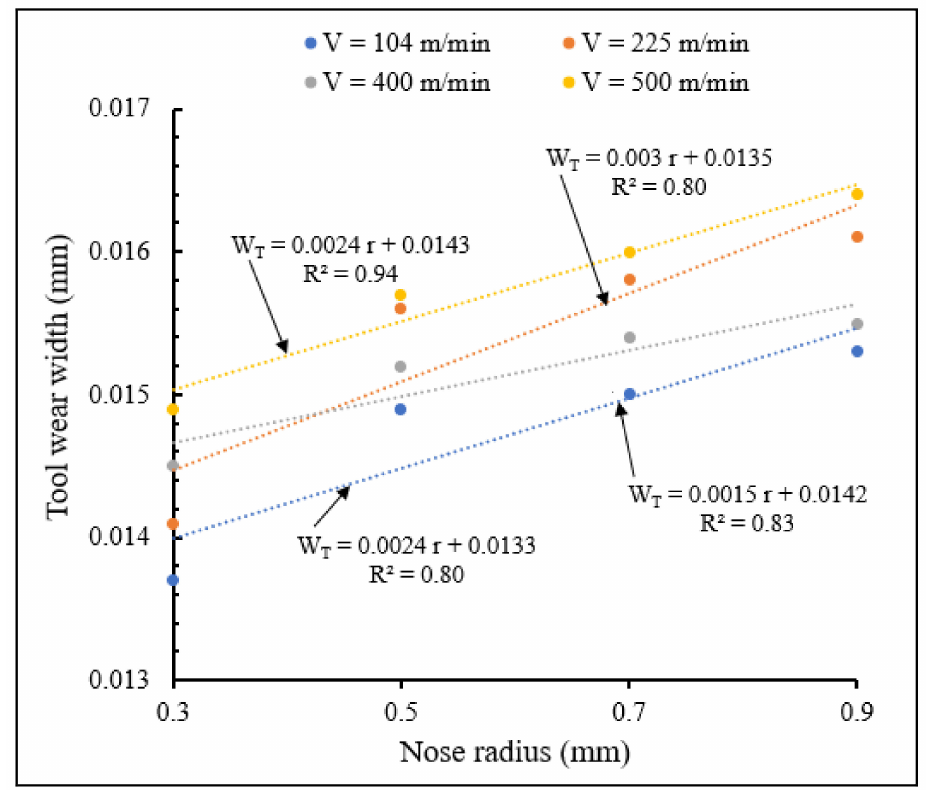
Figure 25. Variation of tool wear width with large nose radius for different cutting speeds at f = 0.1 mm/rev, γ = 5 ◦